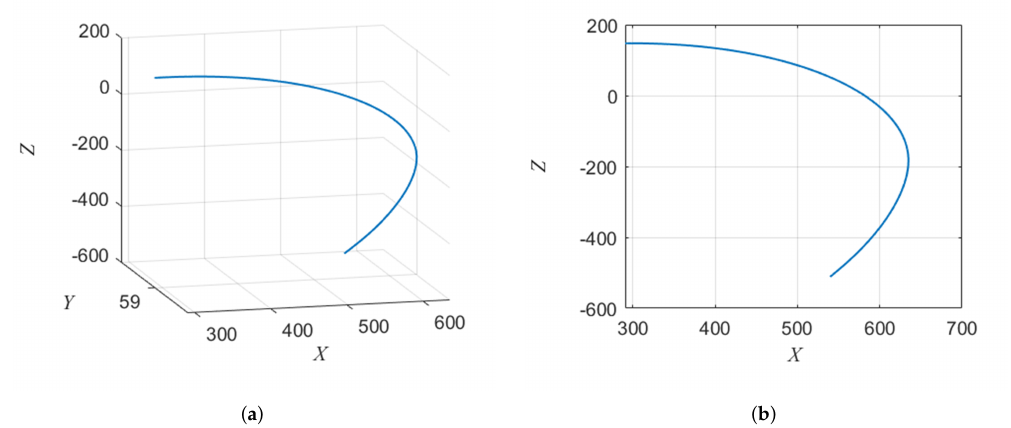
Figure 7. Foot-end trajectory curve. ( a ) Foot-end trajectory curve, ( b ) Trajectory curve in two- dimensional